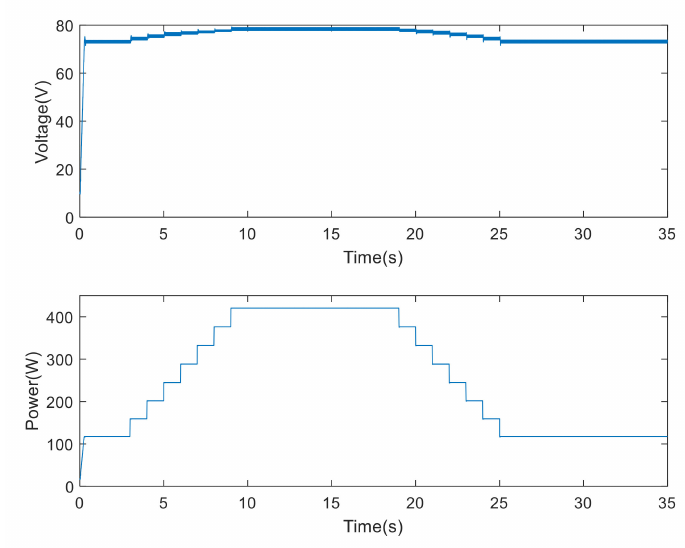
Figure 14. Experimental tracking waveforms of the proposed method under EN50530 test condition. Table 8. Experimental results of five compared MPPT methods under EN50530 test